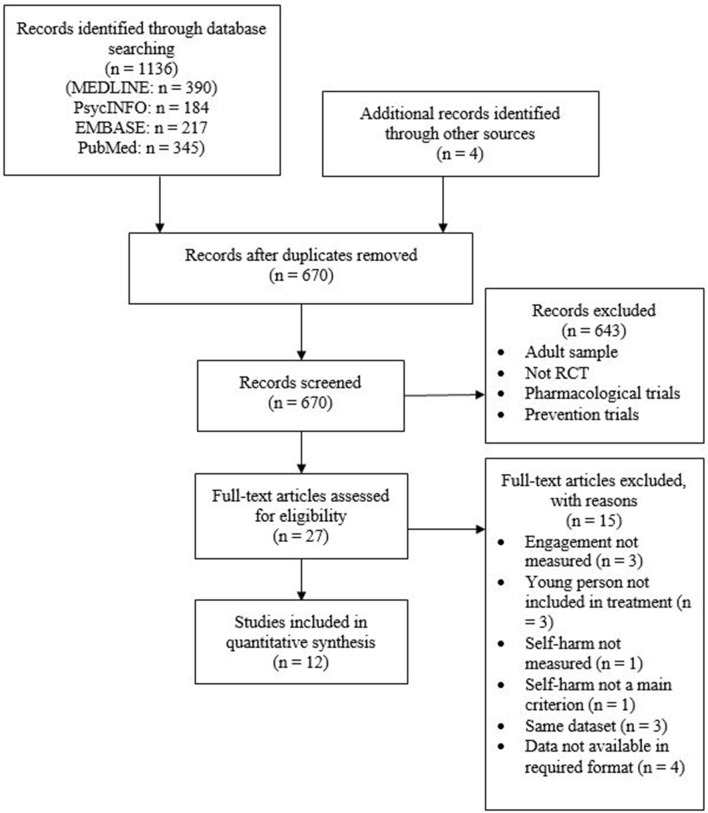
Flow of studies.